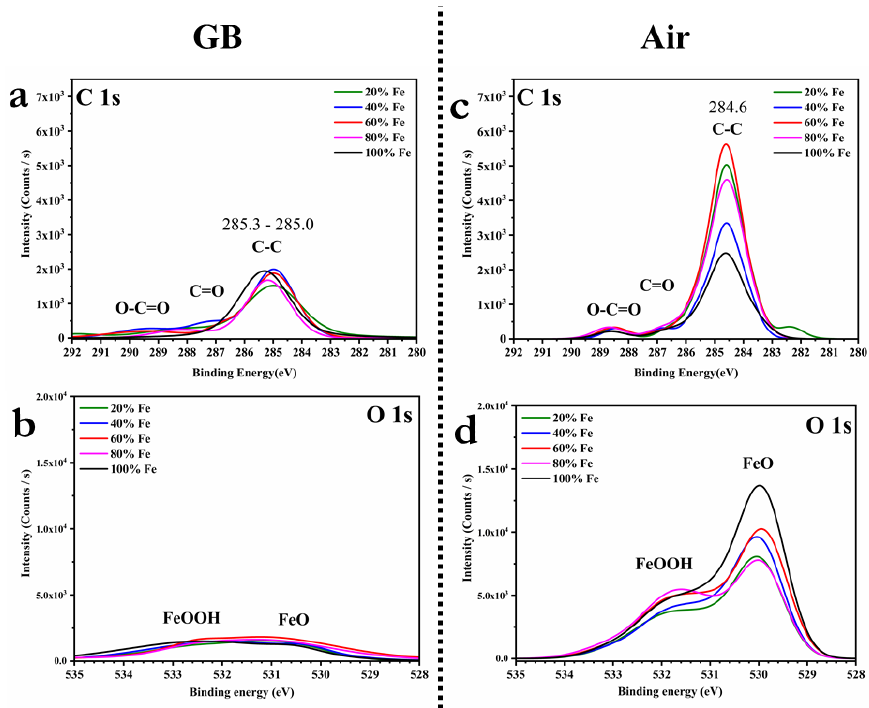
Figure 8. XPS spectra of the high-resolution core level for C 1s and O 1s regions of the 20%, 40%, 60%, 80%, and 100% C(Z,F)TS thin films, made in glovebox ( a , b ) and air ( c,d ).